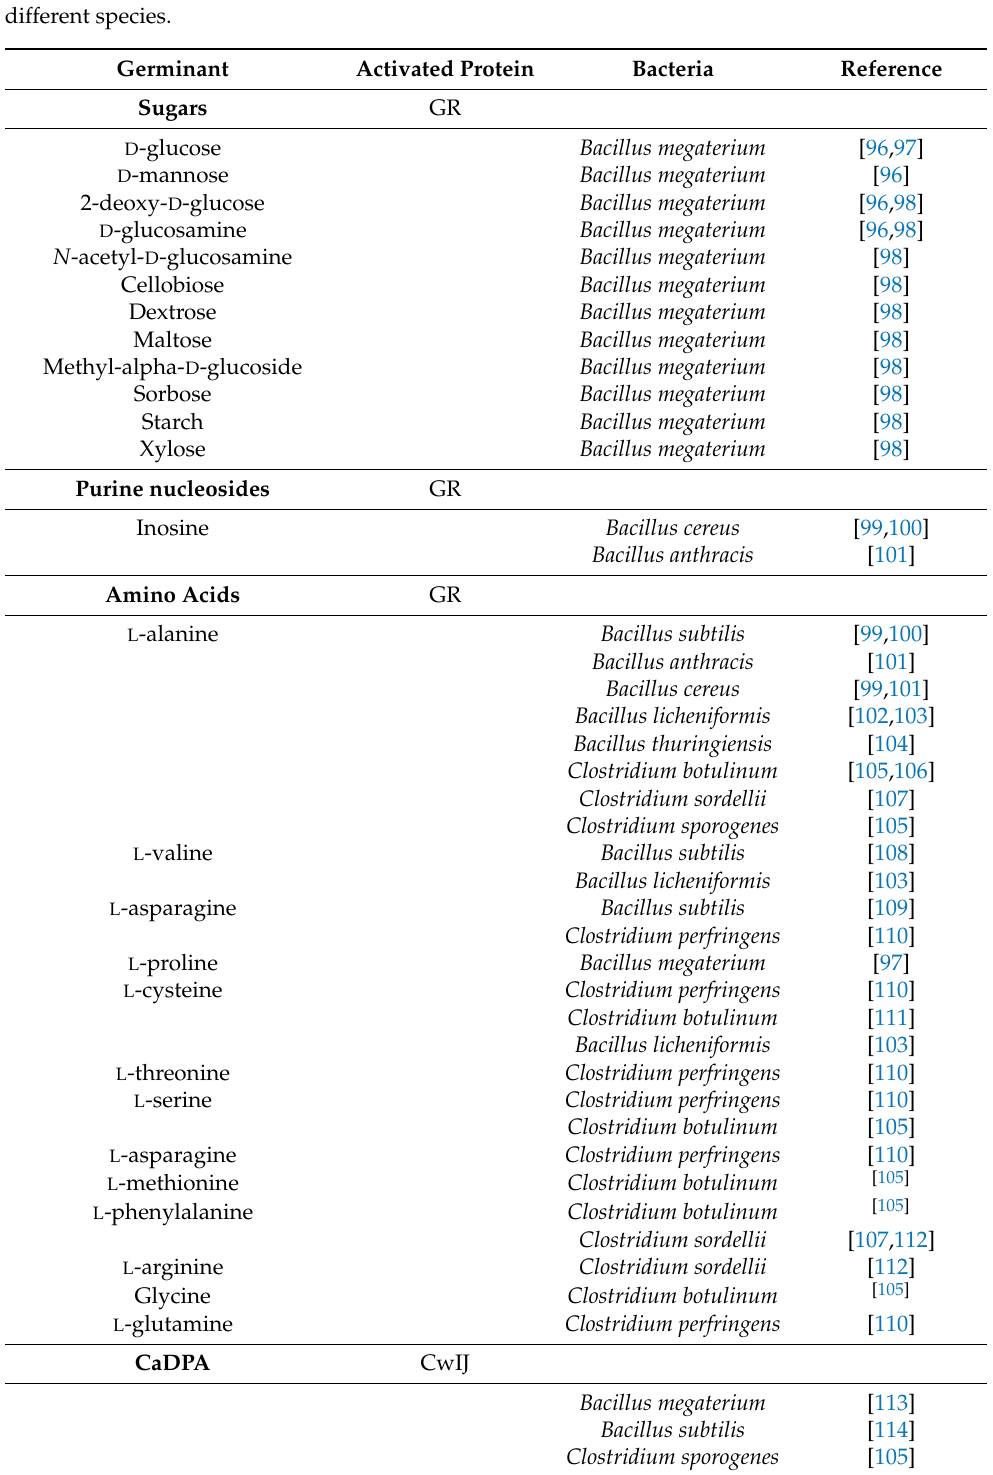
Table 1. An overview of various spore germinants and the protein triggering germination in different